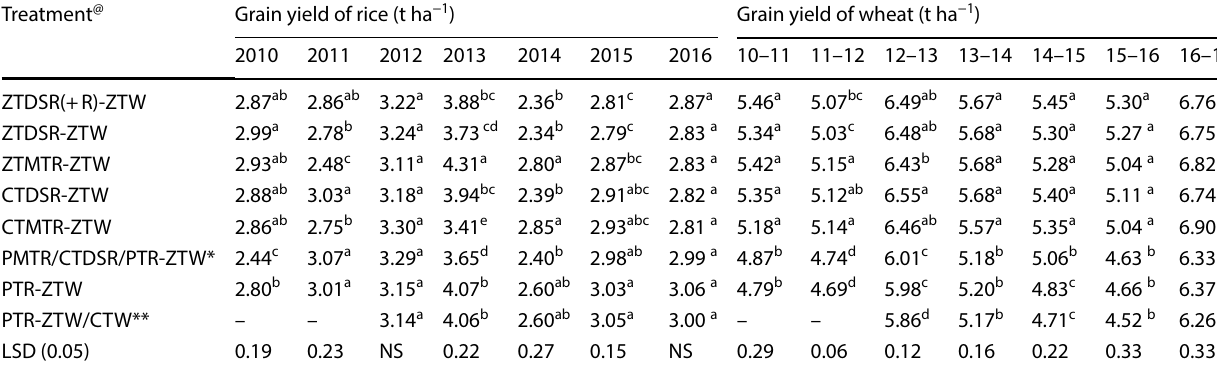
Table 2 Effect of different crop establishment methods on grain yield of rice and wheat rice–wheat cropping system